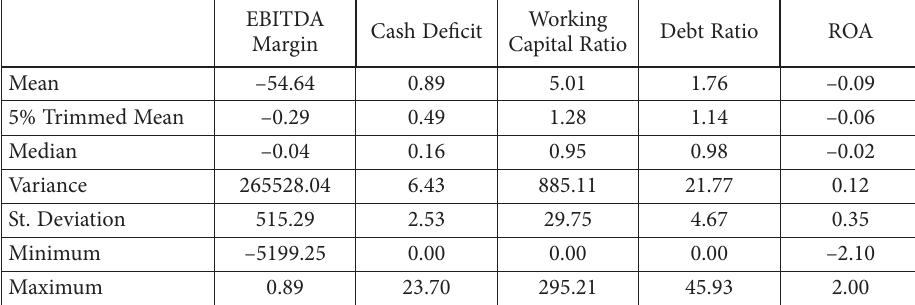
Table 2. Mean and median of chosen ratios (source: author based on Bisnode